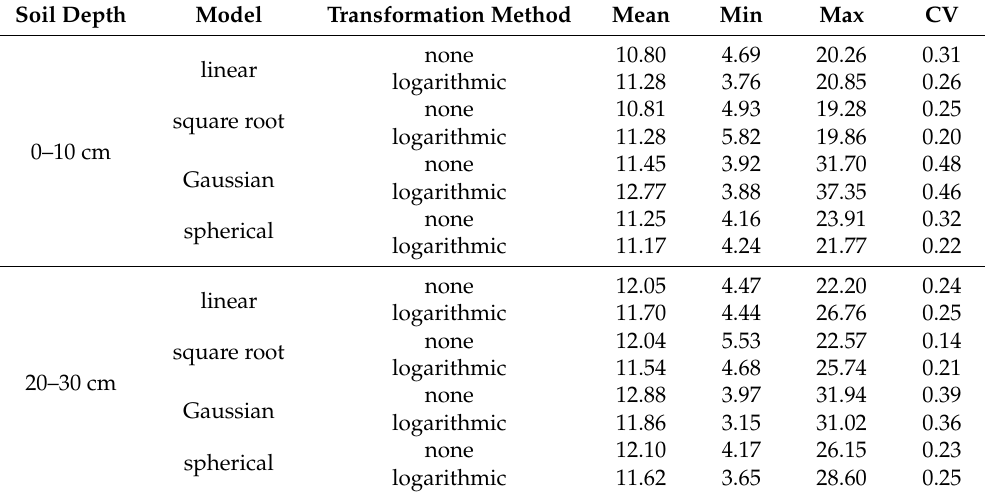
Figure 4. Variograms of mathematical models producing highest inner and outer accuracy. Table 5. Descriptive statistics of the final soil C / N interpolation